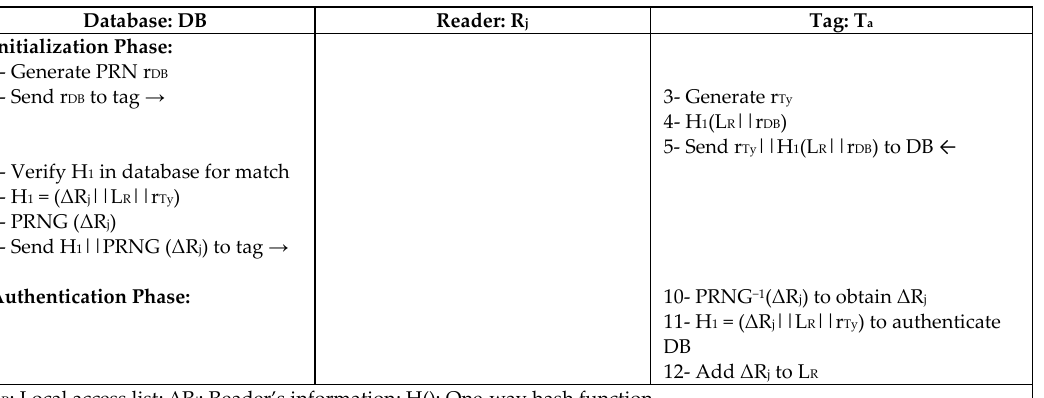
Figure 15. Grouping Proofs-Based Authentication Protocol (GUPA) by Liu for a Single-Reader—Single-Tag Case.